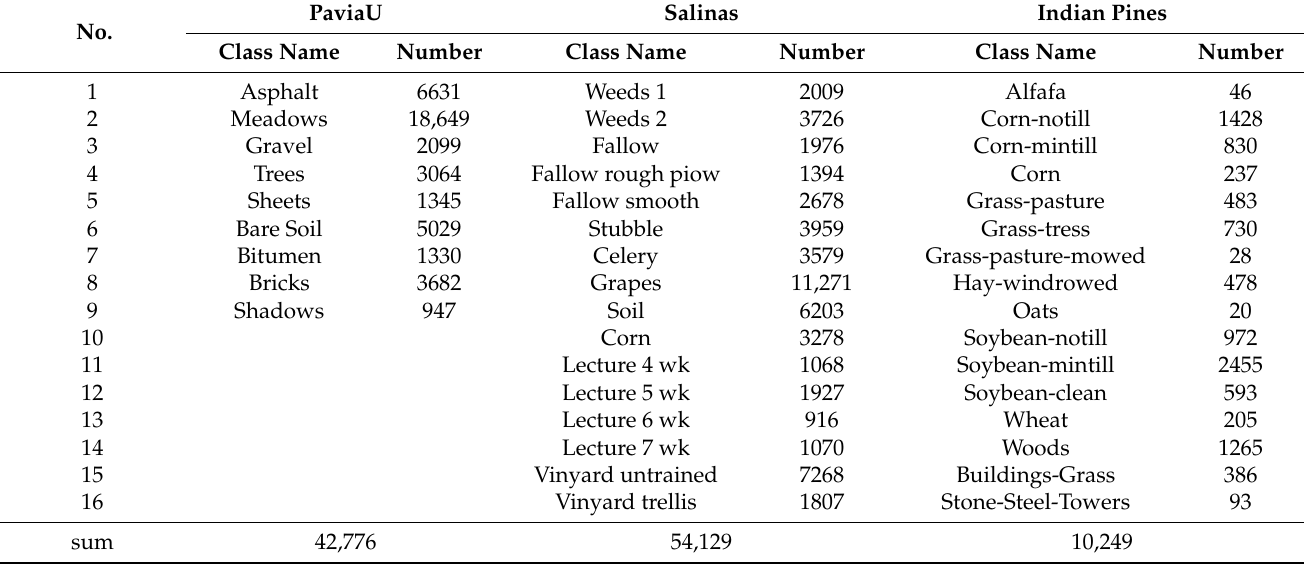
Table 1. The name and number of samples per class on the Indian Pines dataset, PaviaU dataset, and Salinas dataset